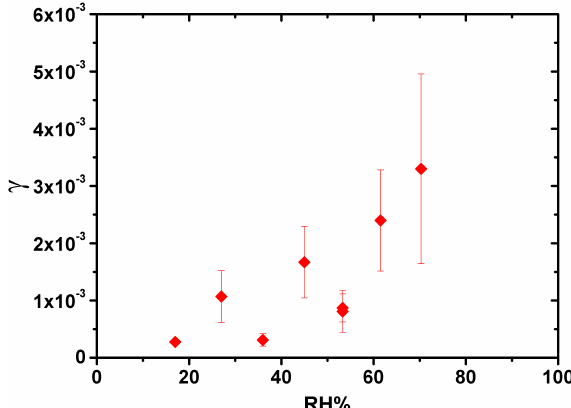
Figure 1. Exemplary traces of inverted detector signals for an ex- periment: teal: gas-phase 13 N 2 O 5 signal; purple: particle-phase 13 N signal; red: SMPS signal (aerosol surface / volume ratio).